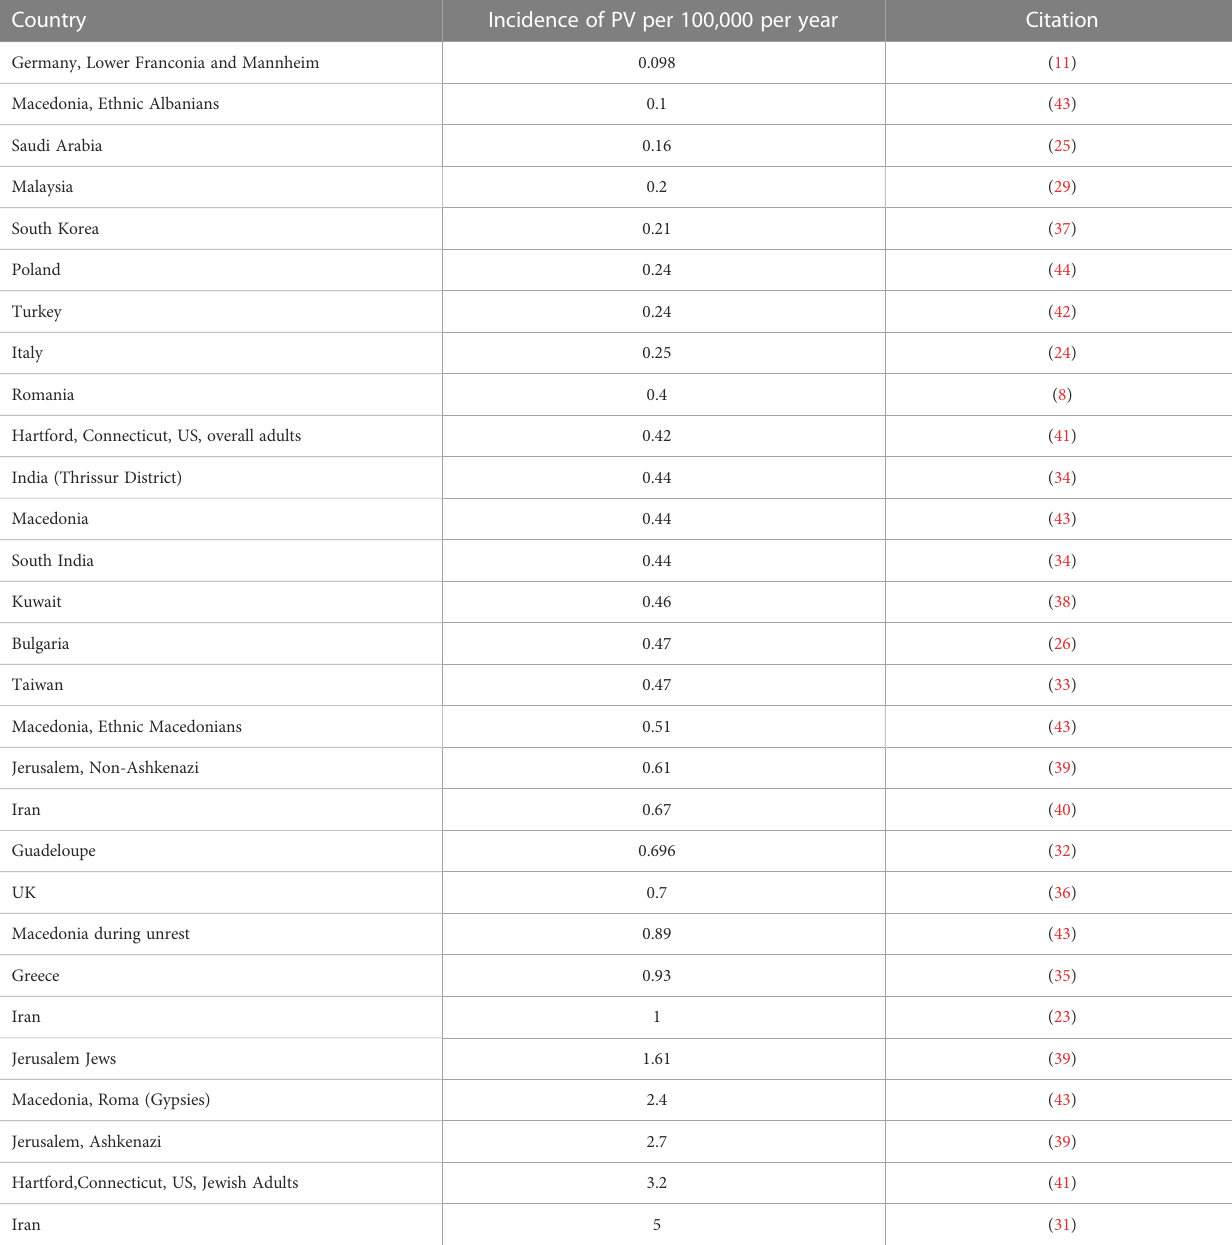
TABLE 2A Incidence of PV by